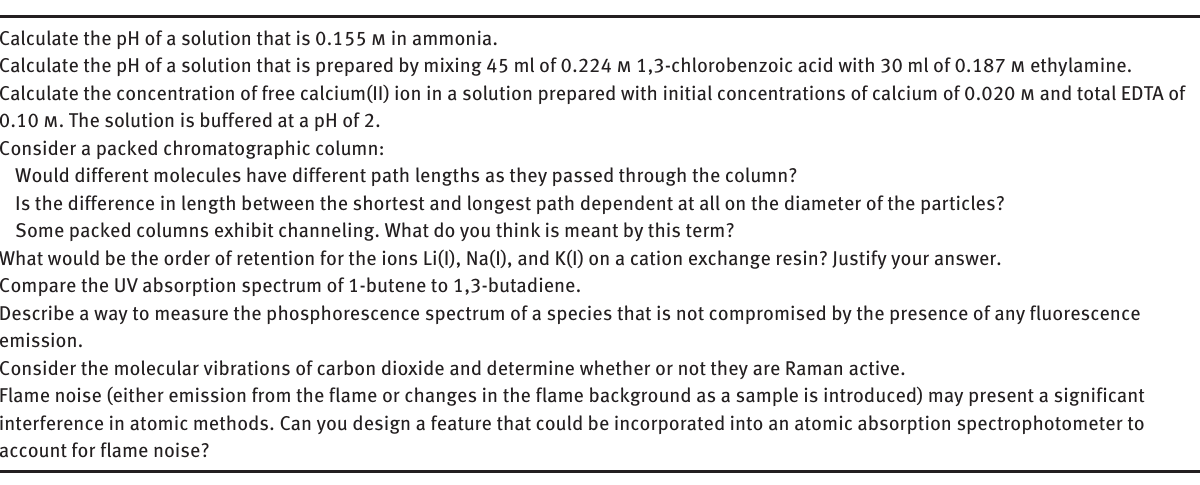
Table 4 Sample in-class questions from the units on chemical equilibrium, separation science, molecular spectroscopy, and atomic